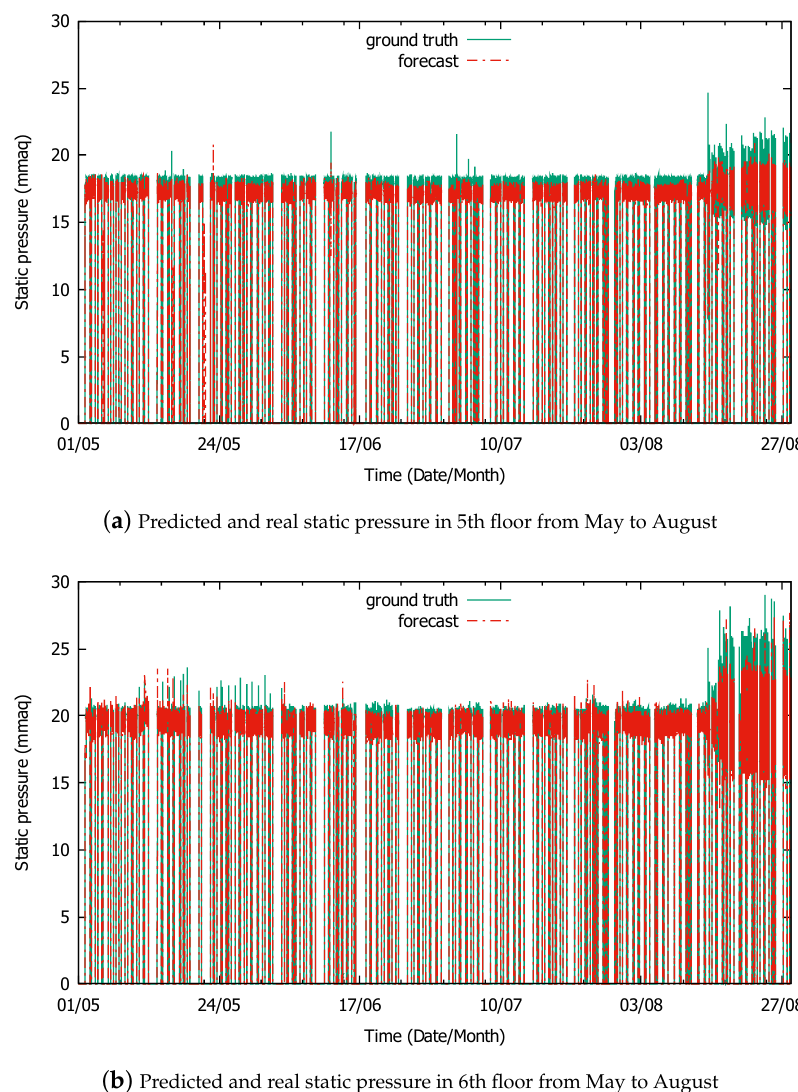
Figure 18. Forecast results for HVAC systems on different